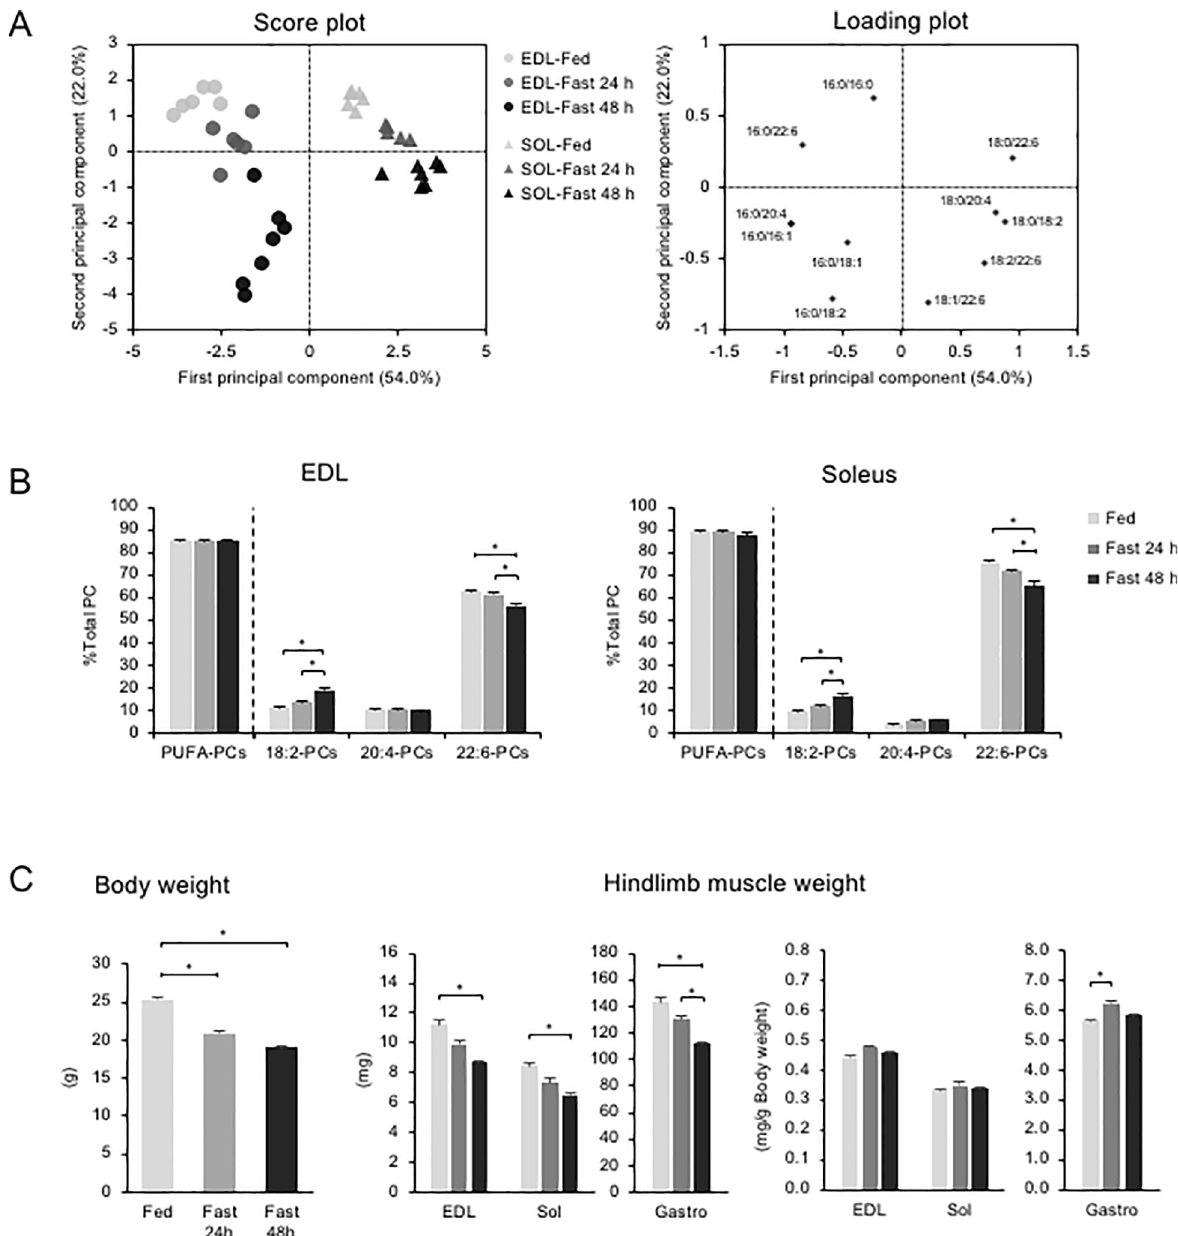
Fig 1. Effects of fasting on skeletal muscle PC profiles. (A) Score plots (left) and loading plots (right) of PCA for measured PC species in EDL and soleus from mice allowed to feed ad libitum (Fed) and those subjected to 24 and 48 h of fasting (Fast). (B) Proportions of each PC group to total PC sorted by acyl-chains at sn-2 position. (C) Body weight and hindlimb muscle weight at dissection. Values represent mean ± SE (n = 5–7); � P < 0.05 (vs. Fed). https://doi.org/10.1371/journal.pone.0255178.g001 18:2-PCs proportion increased, which resulted in no difference in the sum of PUFA-contain- ing PCs between control and STZ-injected mice (Fig 2C). Since both long-term fasting and destruction of pancreatic beta cells by STZ injection cause a reduction in blood insulin levels, insulin concentration might be associated directly or indirectly with fasting-induced phospho- lipid alteration and may play a role in maintaining the proportion of PUFA-containing PCs.